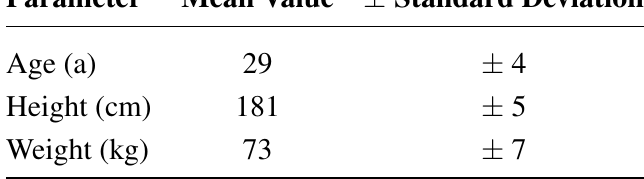
Table 3. Biometric data of the twelve